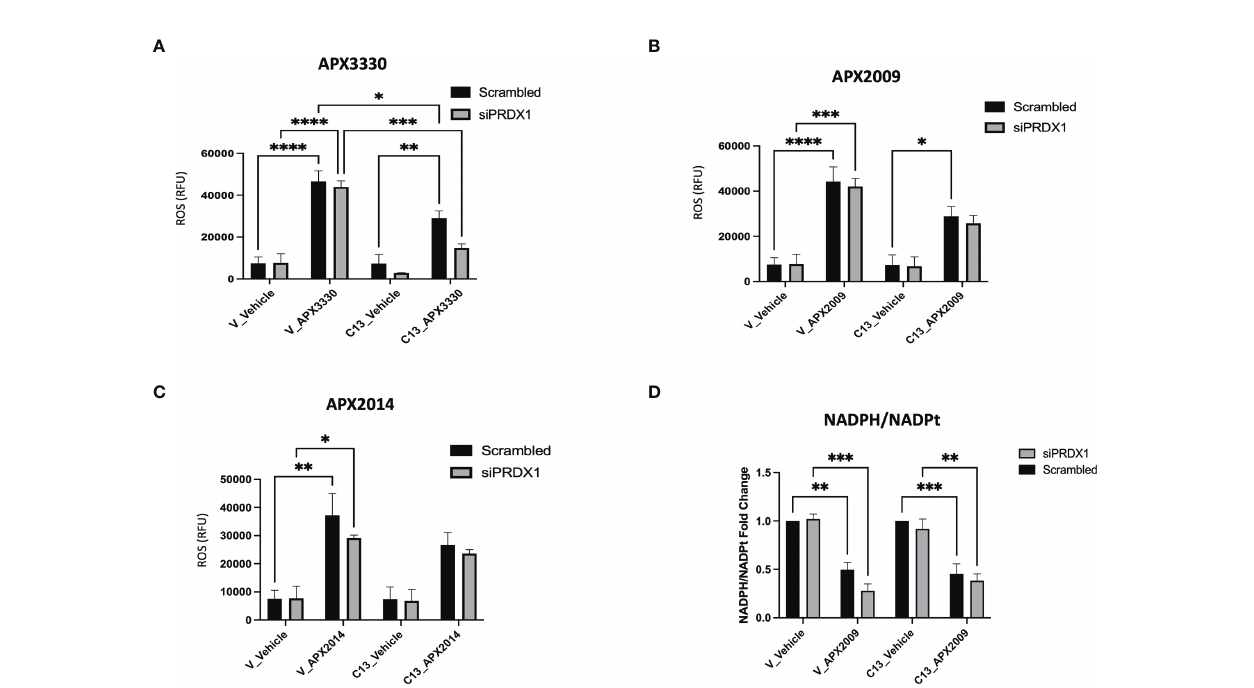
FIGURE 5 | Effects of RelA on cellular redox imbalances caused by Ref-1 inhibitors in PDAC cells. (A – C) intracellular ROS levels were measured upon PRDX1 knockdown cells at 48 hours post-transfection and following 2 hours of Ref-1 inhibitor treatment with APX3330 (75 m M), APX2009 (20 m M), APX2014 (20 m M). These experiments were repeated four times (N=4), and then compared by Two-way ANOVA of *p < 0.05, **p < 0.01, ***P < 0.001, ****p < 0.0001. (D) NADPH/NADPt ratio in PRDX1 knockdown cells (1nM/48h) was assessed following APX2009 treatment (12.5µM/5h). two-way ANOVA, **p < 0.01, ***p < 0.001,